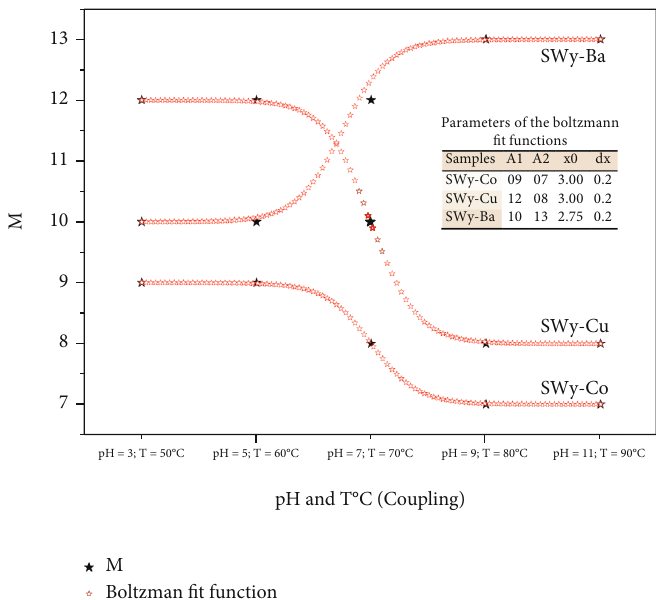
Figure 10: Average number of layers M evolution versus constraint strength in the case of SWy-Co, SWy-Cu, and SWy-Ba samples (black scatter). Red scatter: the used Boltzmann fi